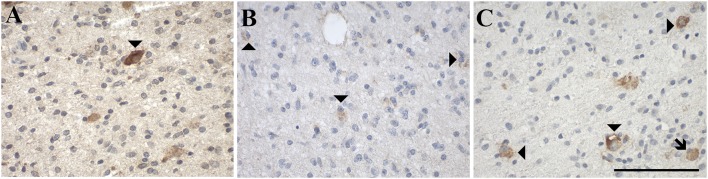
Representative images of immunohistochemical stainings of ganglioglioma (WHO grade I), a mixed neuronal-glial tumor, which show (A) GAL immunoreactivity (case 34), (B) GAL1-R immunoreactivity (case 36), and (C) GAL3-R immunoreactivity (case 34). Arrow heads indicate positive-stained cells whereas the arrow points out a GAL3-R positive GAM. [scale bar: 100 μm].